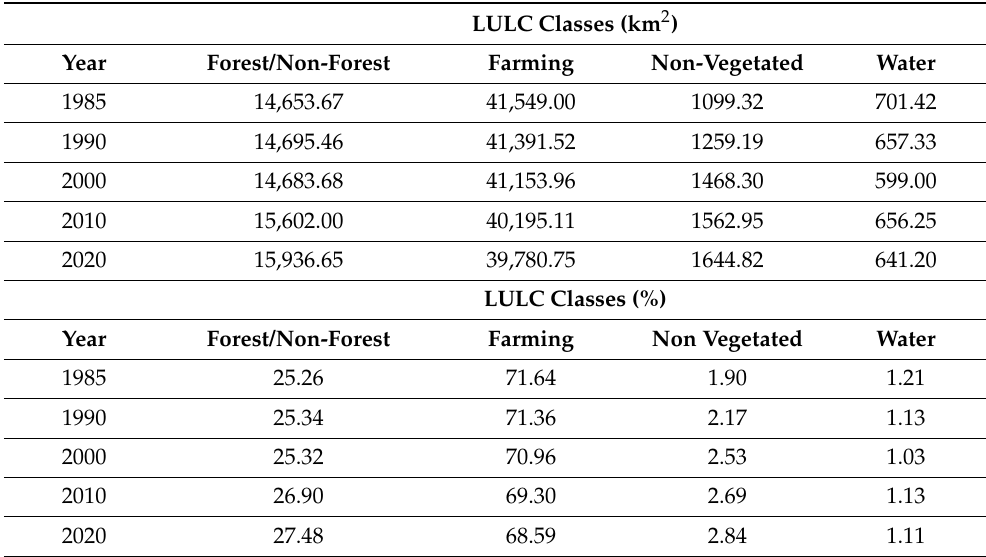
Table 1. Areas of land use and land cover (LULC) classes in the Para í ba do Sul hydrographic basin (PSHB). The percentage data indicate the area classes concerning the PSHB area [88]. LULC Classes (km 2 )